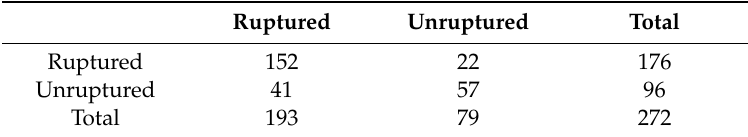
Table 2. Accuracy of the CNN to detect ruptured or unruptured intracranial aneurysms in the test cohort a